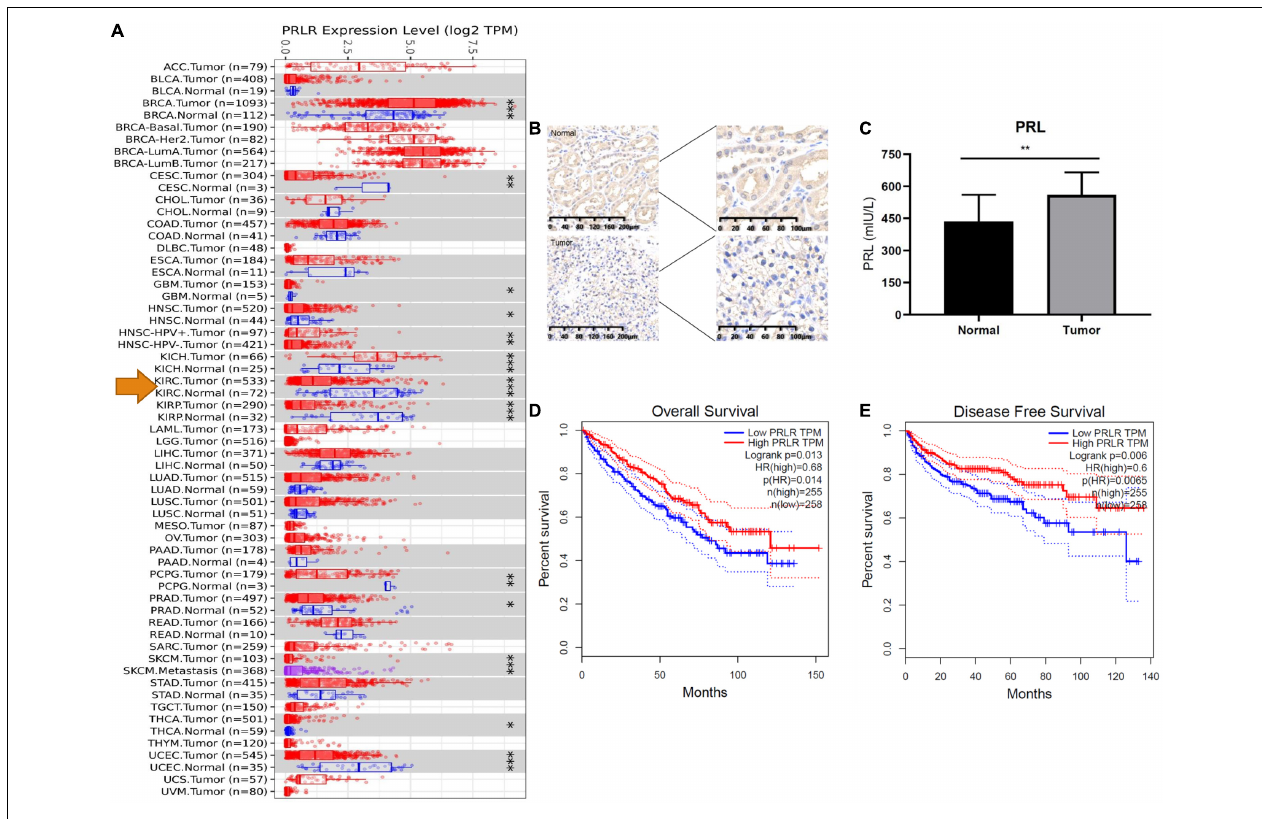
FIGURE 3 | PRL/PRLR signal in ccRCC. (A) PRLR expression is significantly decreased in tumors compared with paracancerous tissues. Tumors and paracancerous tissues were shown in red and blue dots, respectively. The tumors and paracancerous tissues of a certain cancer was in the same gray box (* p < 0.05; ** p < 0.01; *** p < 0.001). (B) PRLR was stained with IHC in the tumor and normal tissue. (C) PRL was quantified with ELISA. (D) The impact of PRLR on the overall survival of ccRCC patients in the TCGA cohort. (E) The impact of PRLR on the disease-free survival of ccRCC patients in the TCGA